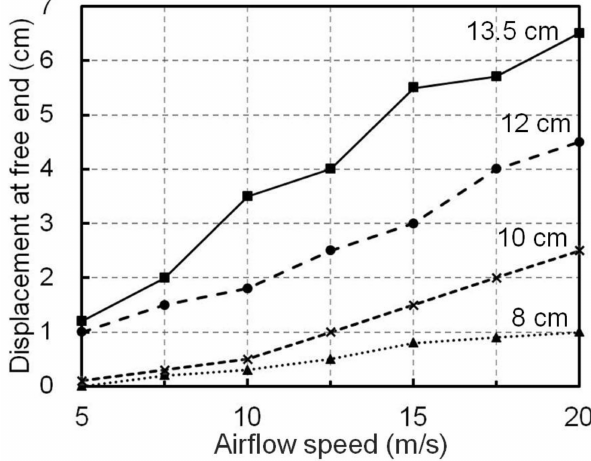
Figure 6. Displacement at the free end of the wind barrier with di ff erent heights subjected to crosswinds at di ff erent